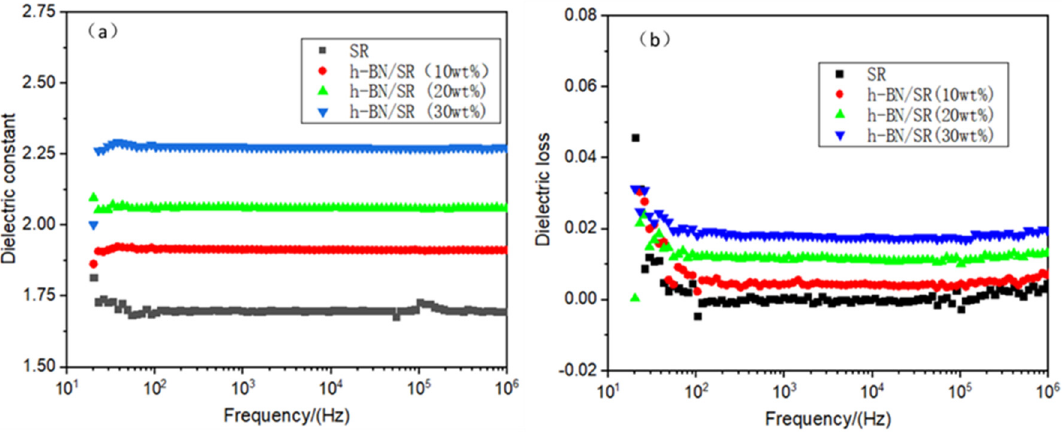
Figure 9. Electrical properties of SR and h-BN/SR composite: ( a ) dielectric constant; ( b ) dielectric loss.